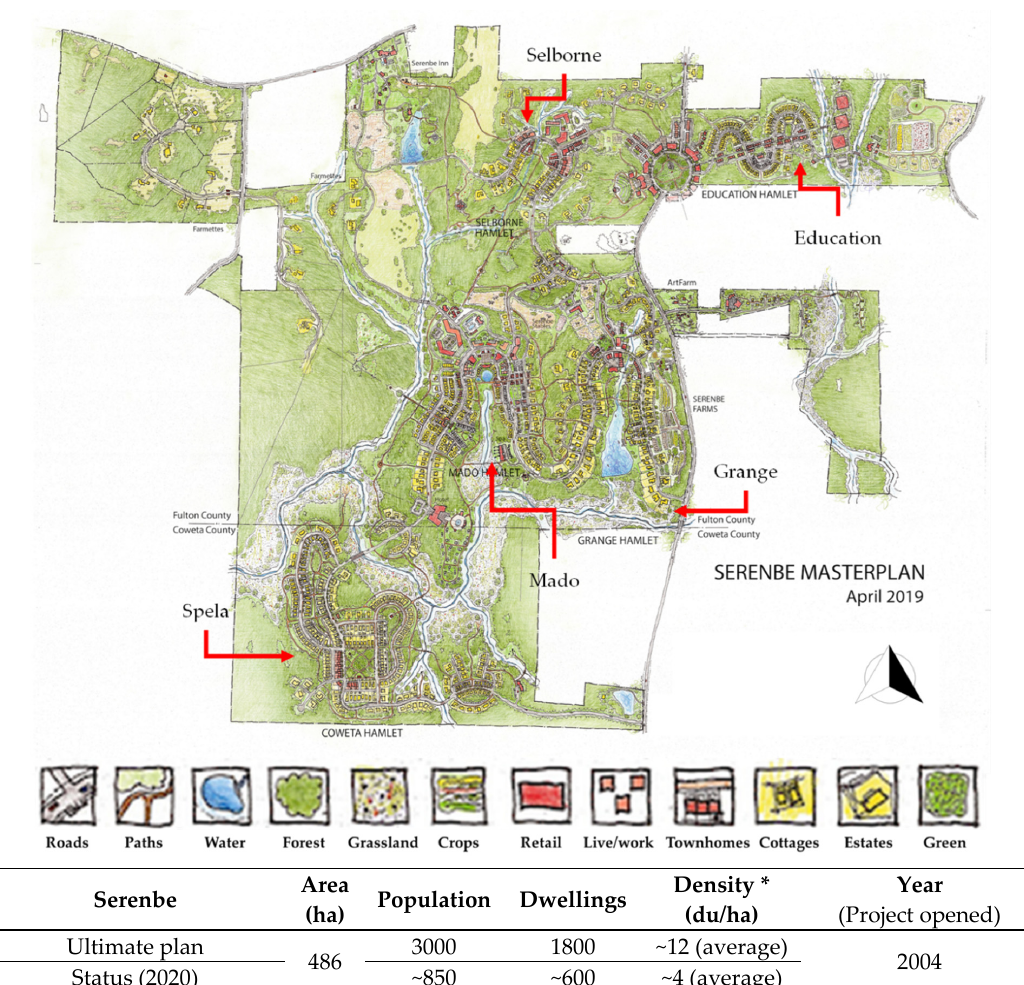
Figure 3. Planning characteristics in the case study of the Serenbe community. Serenbe Commu- nity Masterplan (2019). Source: Serenbe Development; modified from Phillip Tabb’s Masterplan (April 2019). * du/ha = dwelling units/hectare. The open space (70% of the land) is excluded from the density (du/ha).